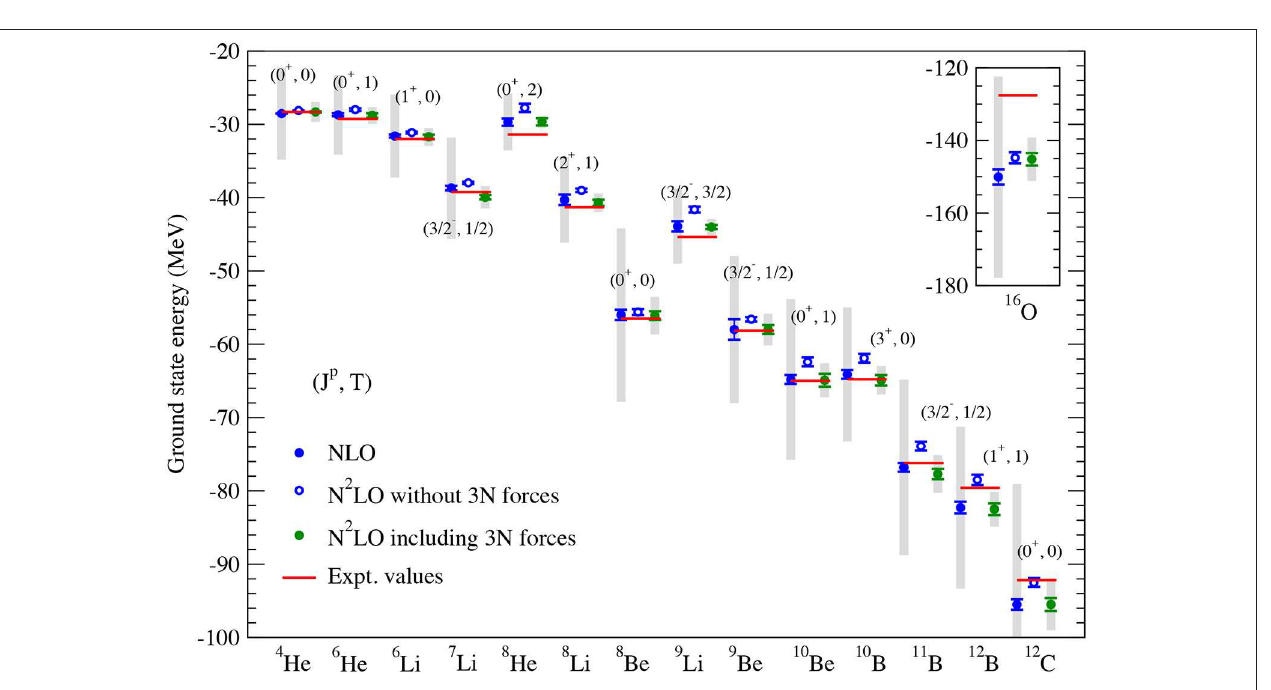
FIGURE 14 | Calculated ground state energies in MeV using chiral SCS NN interactions from Epelbaum et al. [8] in combination with the SCS 3NF at R (open and solid dots) in comparison with experimental values (red levels). For each nucleus the NLO and N 2 LO results are the left and right symbols and bars, respectively. The open blue symbols correspond to incomplete calculations at N 2 LO using NN-only interactions. Blue and green error bars indicate the NCCI extrapolation uncertainty and, where applicable, an estimate of the SRG dependence. The shaded bars indicate the truncation error at each chiral order corresponding to 68% DoB intervals using the Bayesian model ¯ C 650 0.5